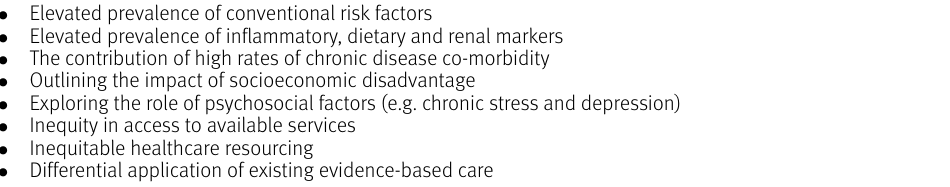
Table 2. Explaining cardiovascular differentials experienced by indigenous